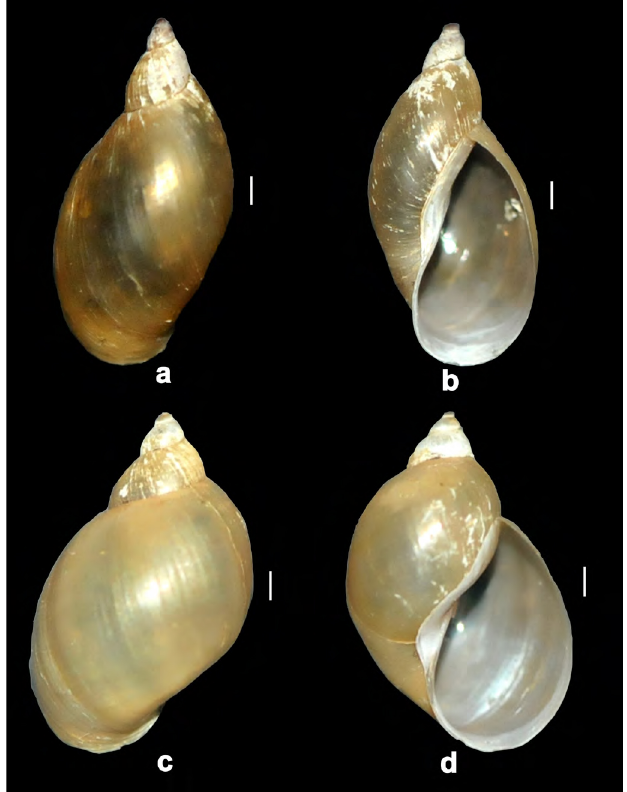
Lymnaea Lymnaea acuminata Shell of cf. Lamarck, 1822 (ZSI- WRC-Moll.1496) (c and d): a and c, abapertural views; b and d, apertural views. Scale bars = 1